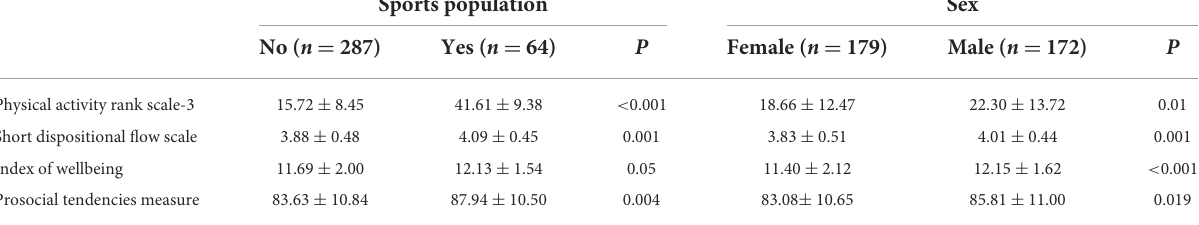
TABLE 1 Means ± standard deviations of variables.